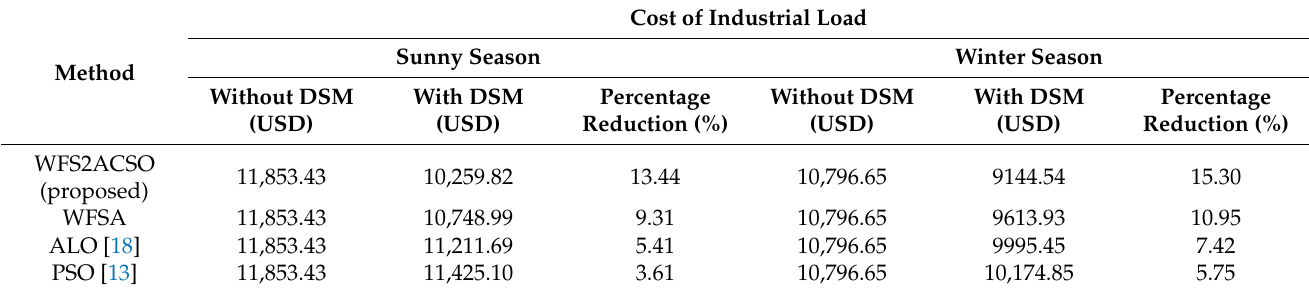
Table 8. Comparison of percentage cost reduction for different optimization methods for industrial load.